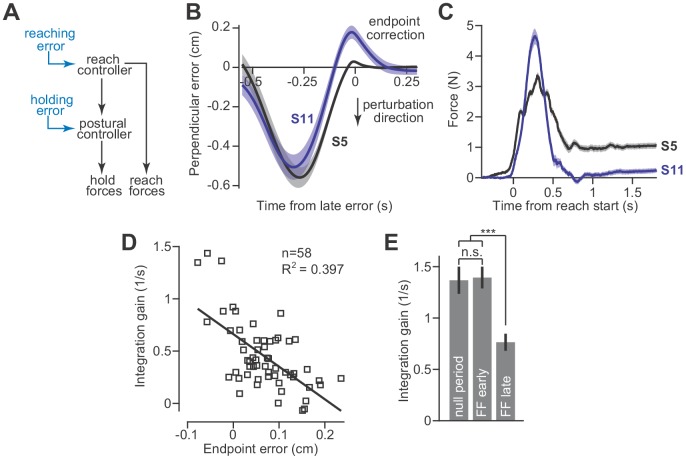
Adaptation of the integration gain.(A) To maintain endpoint stability after adaptation of the reach controller, the postural controller must also adapt. (B) We hypothesized that integrator adaptation would be driven by errors in hand trajectory that occur near the end of the reach. To detect these errors, we looked for deviations in the reach trajectory after the reach exceeded 80% of its displacement. We spatially aligned reaches by subtracting off the terminal hand position and then temporally aligned the reach trajectories to the point in time at which the hand had the largest endpoint error. These errors are marked as ‘endpoint correction’. Here, we show the average reach trajectory during adaptation to a gradual force field for two subjects, one who exhibited integration (S5), and one who did not (S11). (C) The average forces produced at the end of adaptation for the same two subjects. Note that the subject with large errors near reach endpoint no longer generated holding forces at the end of adaptation. (D) We measured the gain of integration at the end of the adaptation period, for subjects that adapted to gradual force fields. We also measured the magnitude and sign of the late reach errors. Larger errors led to a reduction in gain. Each data point is one subject. (E) To confirm that the integration gain changed over the course of adaptation, and not immediately upon introduction of the force field, we compared the gain during the null period, with gains measured during early and late parts of adaptation using a repeated measures ANOVA. Values are mean ± SEM across participants. Statistics: ***p<10−3 and n.s. p>0.05.Figure 6—source data 1.The EXCEL source data file contains data for panels D and E of Figure 6.In the ‘data-panel-D-force-field’ tab, we report the endpoint error (labeled ‘endpoint correction’ in Figure 6B) measured on all trials in the force field period for each participant. In the ‘data-panel-D-channel’ tab, we report the holding forces and the integral of moving forces measured on channel trials at the end of the adaptation period for each participant. In the ‘data-panel-D-gain-and-error’, we provide single measures of endpoint error and integration gain for each participant, obtained from post-processing of the data provided in the prior two tabs. In ‘data-panel-E’, we provide the integration gain measured for each subject during the null period, early during force field adaptation, and late in force field adaptation. The ‘readme’ tab describes all quantities reported in the other four tabs containing participant data.